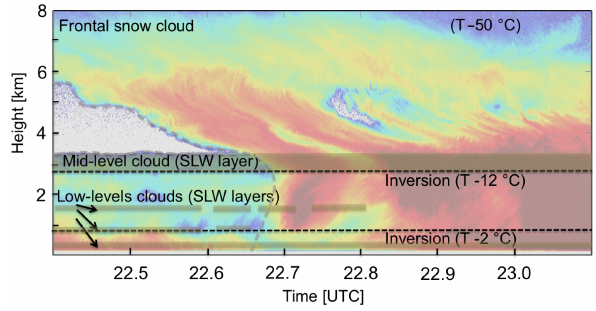
Figure 3. A schematic diagram of the cloud layers present in Hyytiälä on 21 February 2014. Sketch is overlying the KAZR re- flectivity.